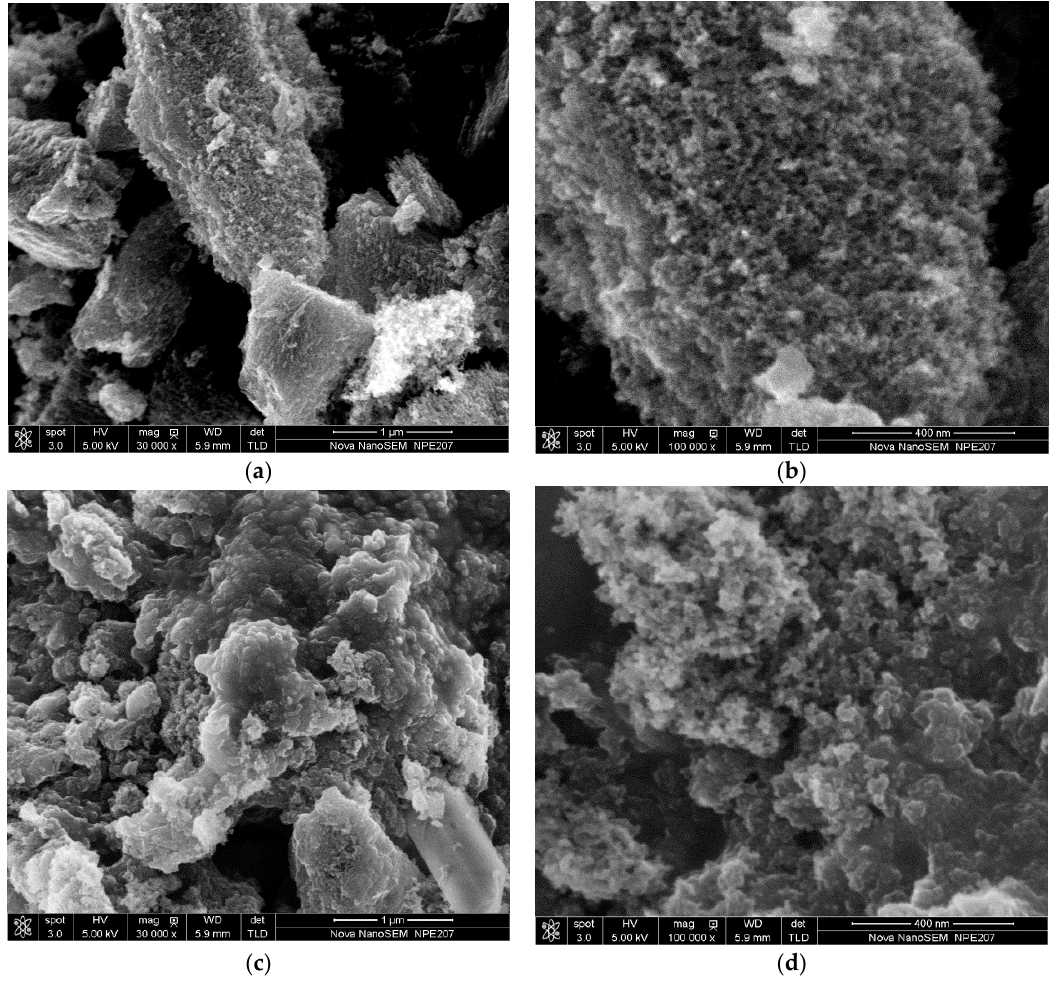
Figure 2. SEM images of WPAC (( a , b ) before Cr(VI) adsorption and ( c , d ) after Cr(VI) adsorption, at pH 3. Scale bars: ( a ) 1 μ m; ( b ) 400 nm; ( c ) 1 μ m; and ( d ) 400 nm).